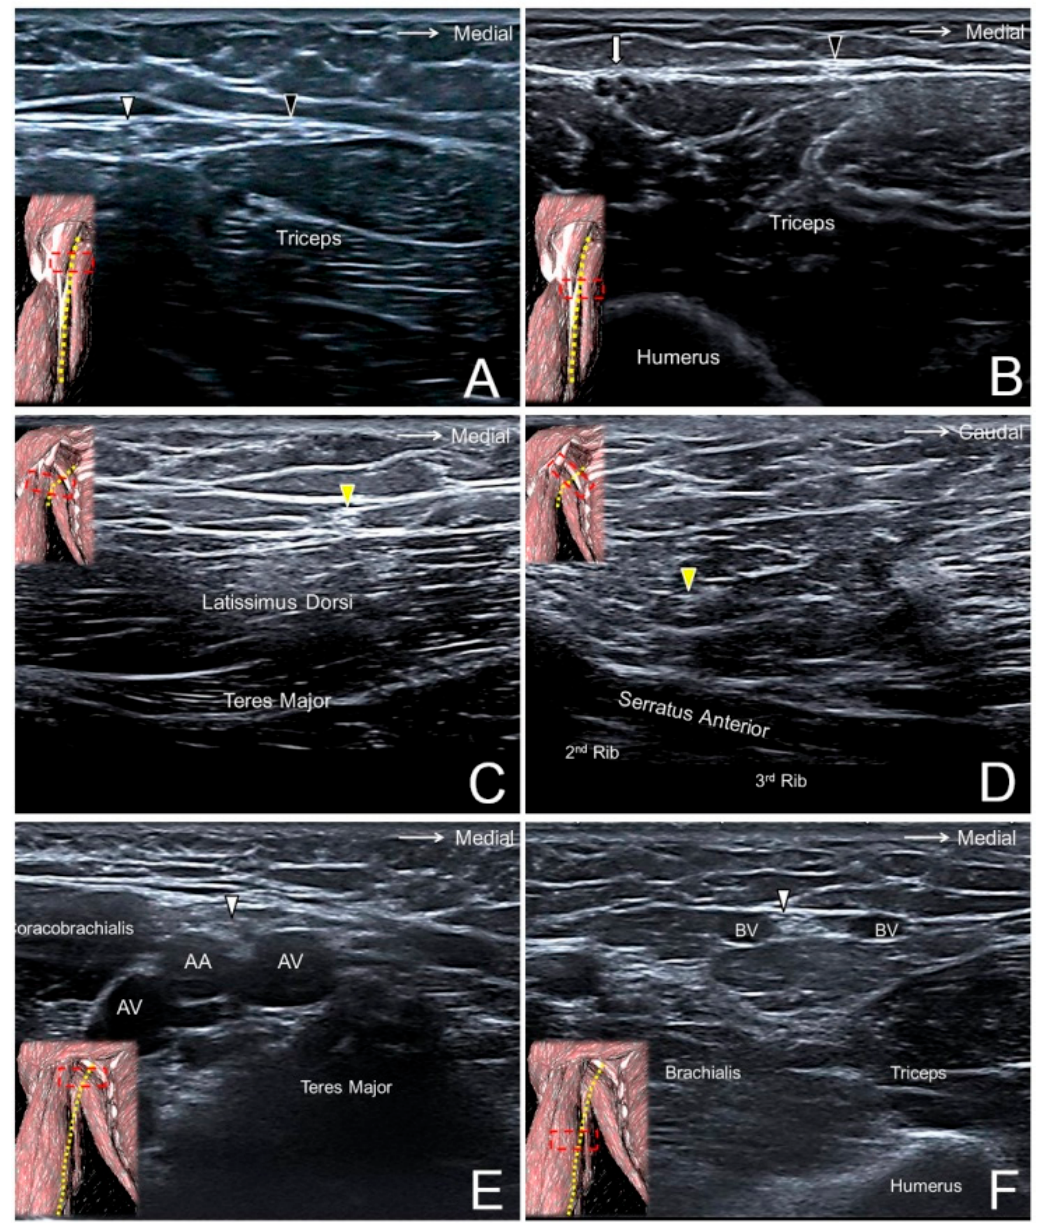
Figure 2. The medial brachial cutaneous nerve (black arrowhead) at the level of the proximal (A) and distal (B) arm. The intercostal brachial cutaneous nerve (yellow arrowhead) superficial to the latissimus dorsi muscle (C) and next to the nerve’s exit from the 2nd intercostal space (D) . The antebrachial cutaneous nerve (white arrowhead) at the level of the axillary fossa (E) , the proximal (A) , and the distal (F) arm. White arrow, ulnar nerve; AA, axillary artery; AV, axillary vein; BV, basilic vein.